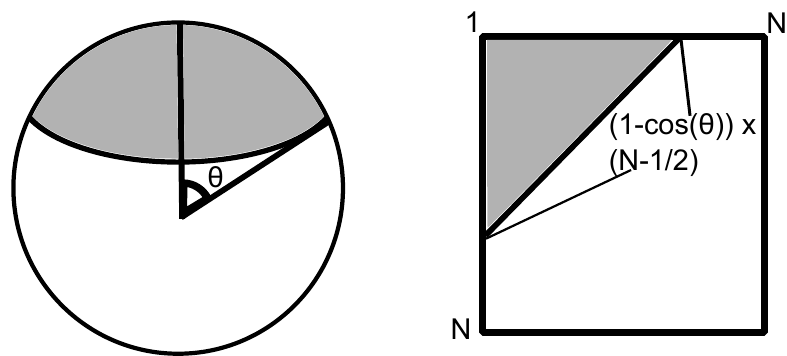
Figure 1 . Degrees of freedom on a polar cap and the corresponding matrix elements. Figure taken from